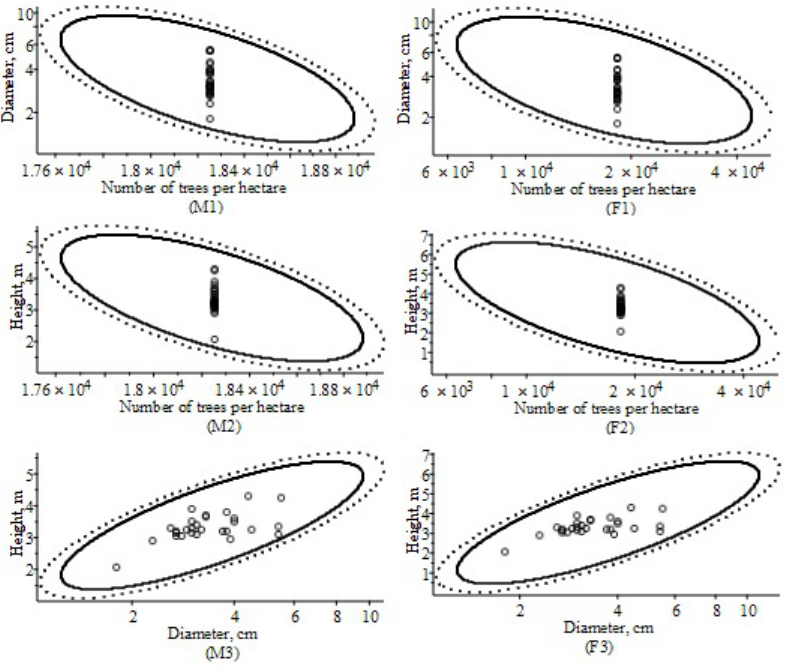
Figure 2. The tolerance regions with the observed data points for a randomly selected stand from a validation dataset (age = 88 years, γ = 0.95): ( M1 – M3 ) mixed-e ff ects scenario; ( F1 – F3 ) fixed-e ff ects scenario; tolerance level β = 0.90, solid line; tolerance level β = 0.95, dotted